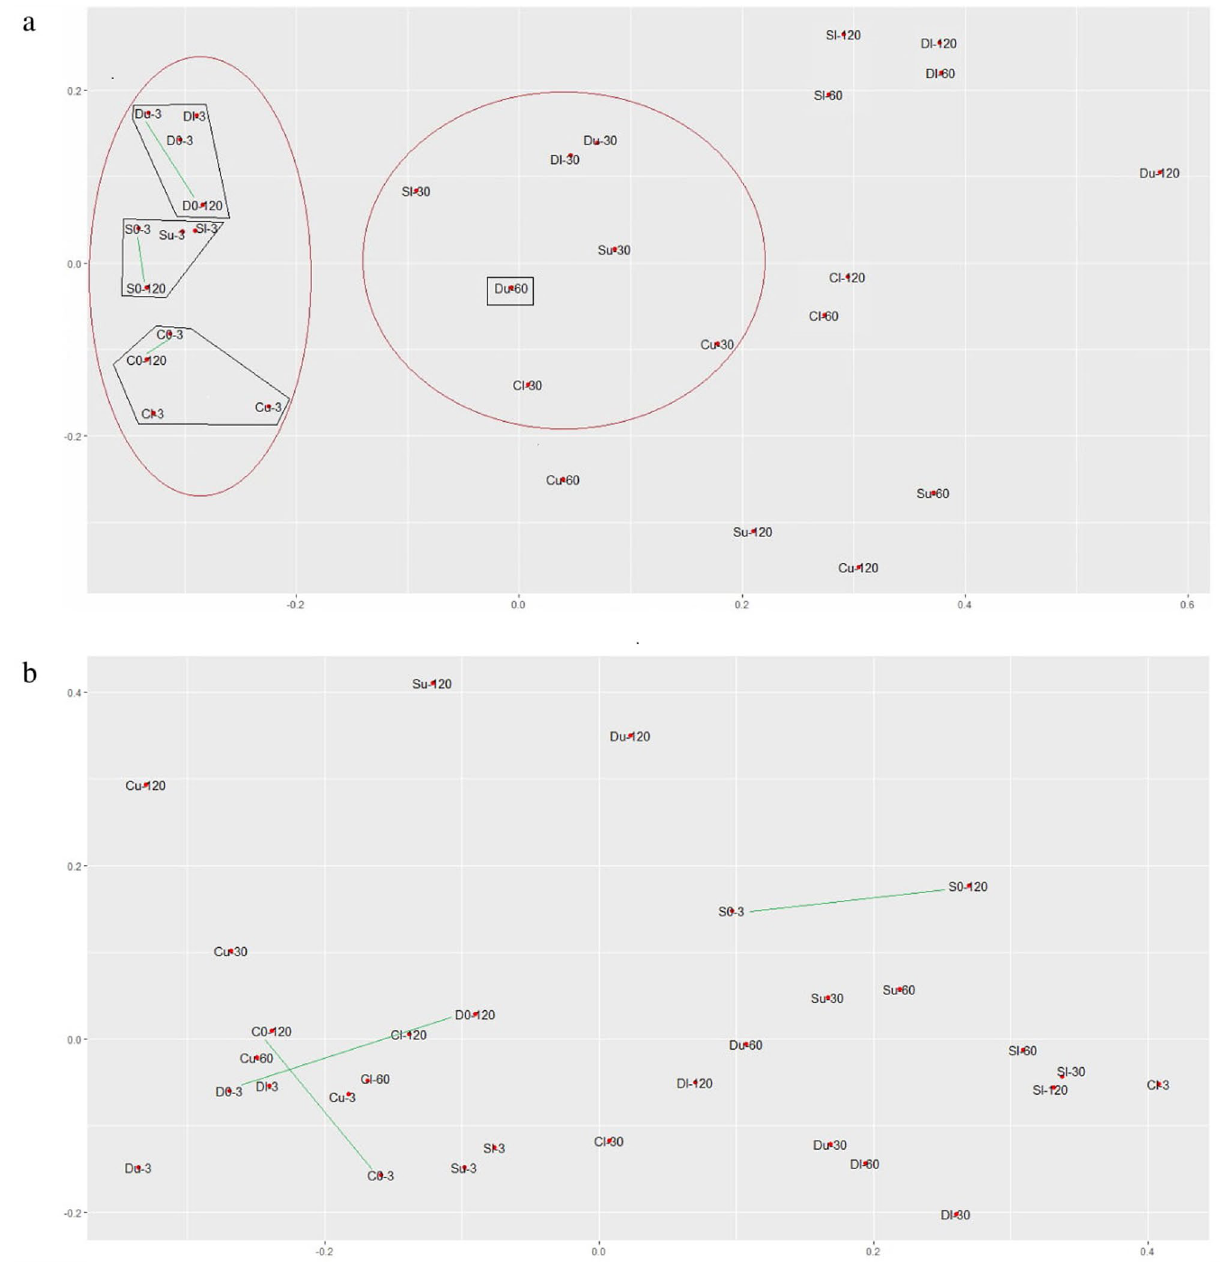
Figure 8. Boxplots illustrating alpha-diversity indexes (observed OTUs ( a ), evenness ( b ), and the Simpson ( c ) and Shannon ( d ) indexes) in bacterial (solid lines) and fungal (dashed lines) communities, where I—soils of various types (D, S, C); II—soils with different pollution levels (I, u); III—soils on the 0th, 30th, 60th and 120th days of the experiment. Median values and interquartile ranges are indicated in the